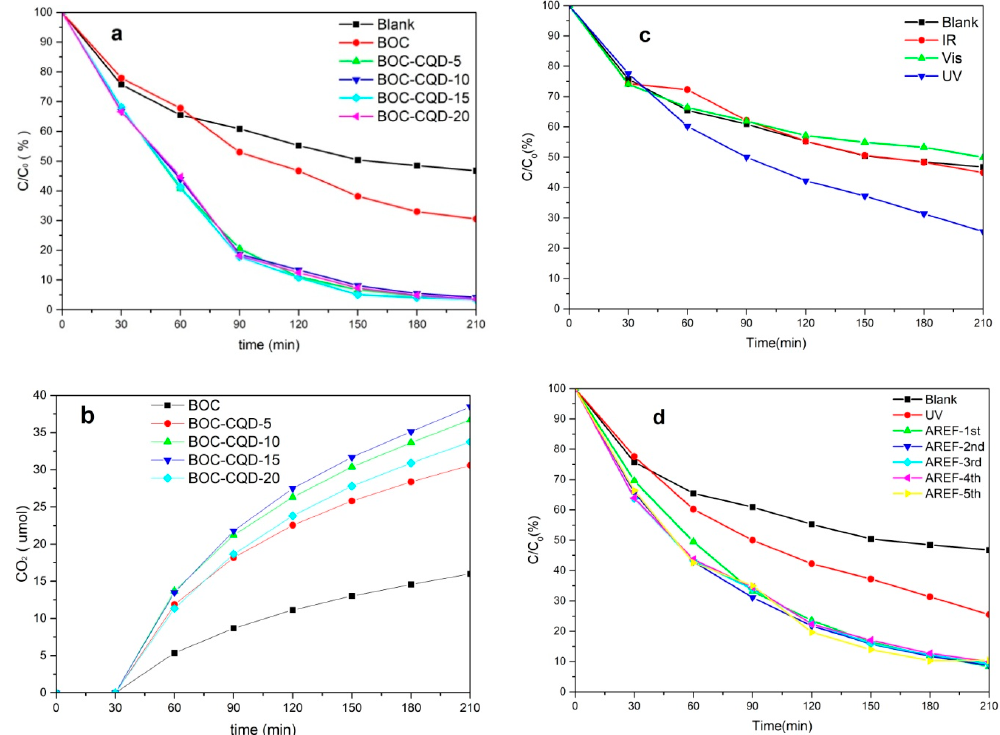
Figure 6. The photocatalytic properties of the as-prepared samples for toluene removal in air ( a ), the CO 2 productivity of the samples ( b ), the ability of BOC-CQD-15 under IR, Vis, UV irradiation ( c ) and the stability of BOC-CQD-15under full light during five cycles ( d ).